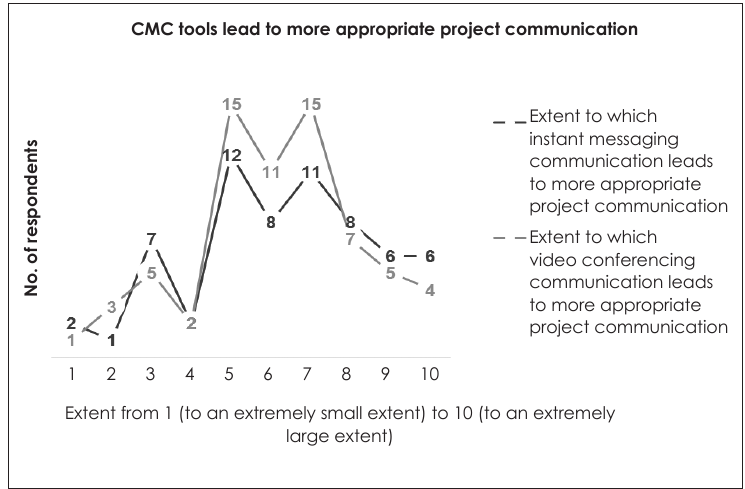
Figure 8: The extent to which CMC tools lead to more project communication Of the respondents, 62% stated that IM communication, to various degrees, leads to an increased amount of project communication. Likewise, 62% of the respondents also perceived VC communication to lead to an increased amount of project communication. This finding is very positive for project communication, as frequent communication between project team members is beneficial, because timely communication in projects results in the completion of projects and project success (Dalcher, 2009; PMI, 2013). An additional question was also posed to the survey participants to determine whether IM or VC communication in projects increases or decreases the quality/effectiveness of the communication if the team is geographically dispersed (see Figures 9 and